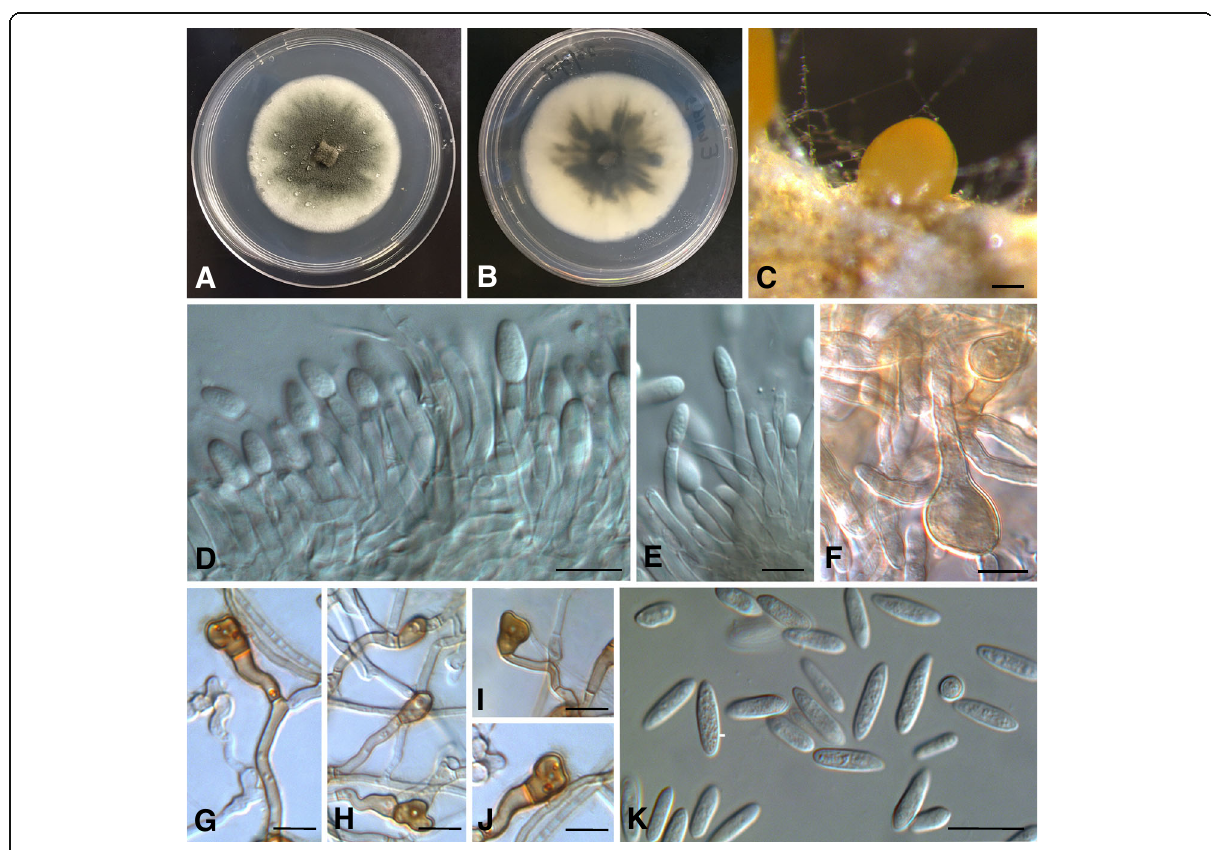
Fig. 6 Colletotrichum javanense (CBS 144963). a Colony on PDA. b Reverse side of the colony on PDA. c Conidioma on PDA. d-e Conidiophores and conidia. f Chlamydospores . g – j Appressoria. k Conidia. Bars = 10 μ